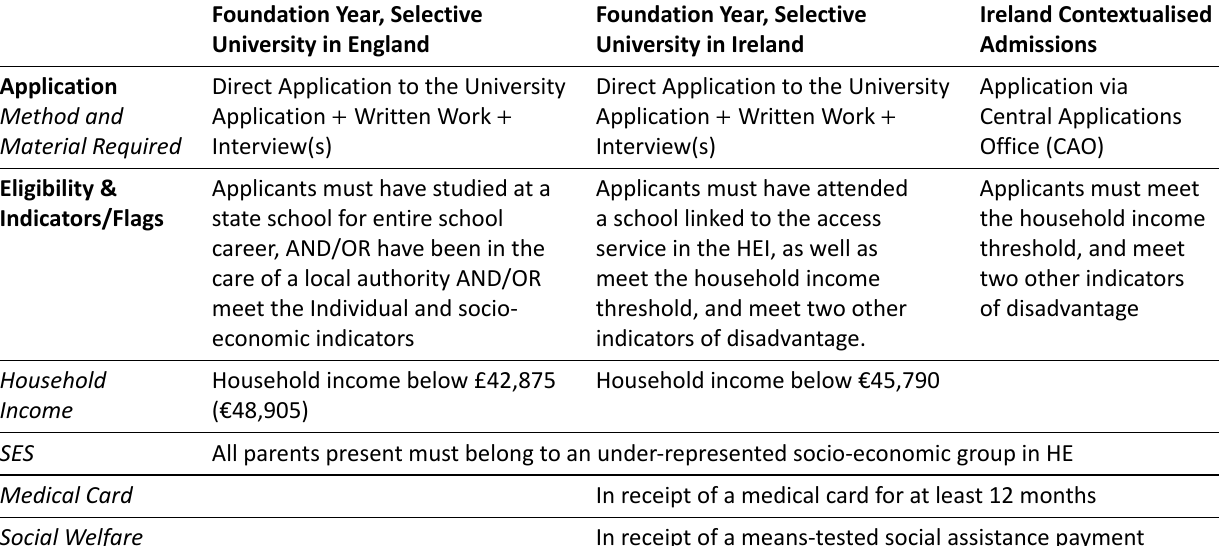
Table 1. Key characteristics contextualised admission in Ireland and foundation years in two selective universities in Ireland and